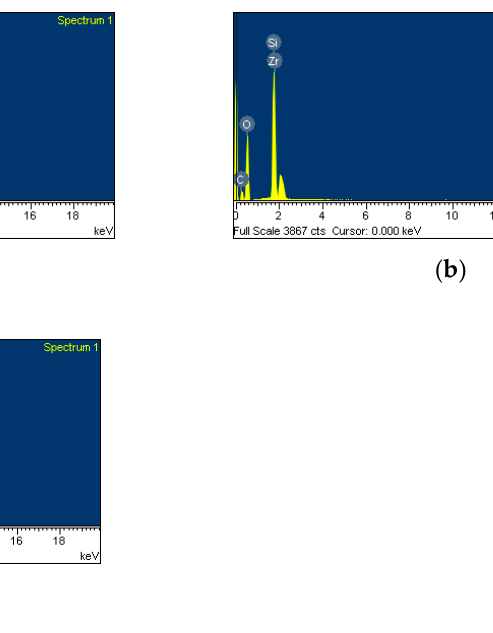
Figure 5. EDS spectrum data for SiO 2 @ZrO 2 : ( a ) 0.04M; ( b ) 0.06M; ( c ) 0.08M calcined at 700 °C.